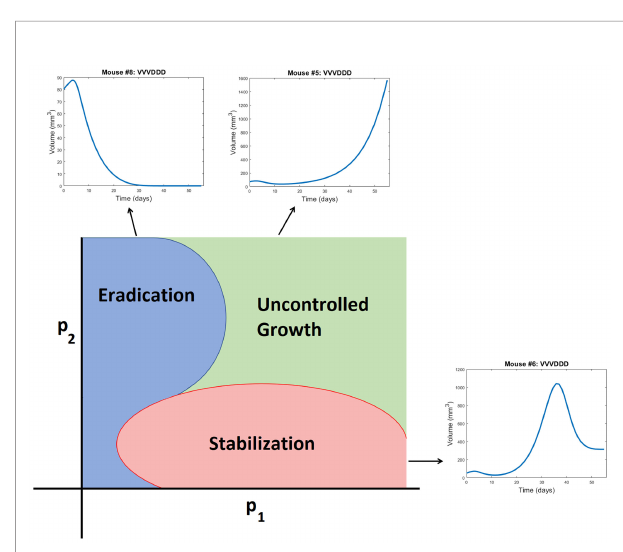
FIGURE 5 | Schematic representation of a bifurcation diagram in two- dimensional parameter space. For certain nonlinear combinations of parameters, a treatment can successfully eradicate a tumor (as occurs for Mouse 8 treated with VVVDDD according to NLME parameters), result in tumor stabilization (as occurs for Mouse 6 treated with VVVDDD according to NLME parameters), or can fail to control the tumor (as occurs for Mouse 5 treated with VVVDDD according to NLME parameters). Note the bifurcation diagram is dependent on both the dose of drug being given, and the ordering of those